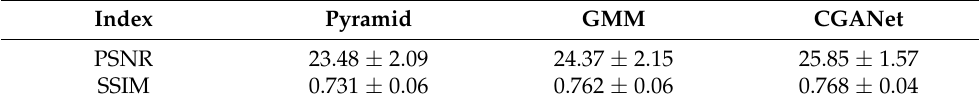
Table 3. Quantitative comparison between different de-raining methods (mean ±